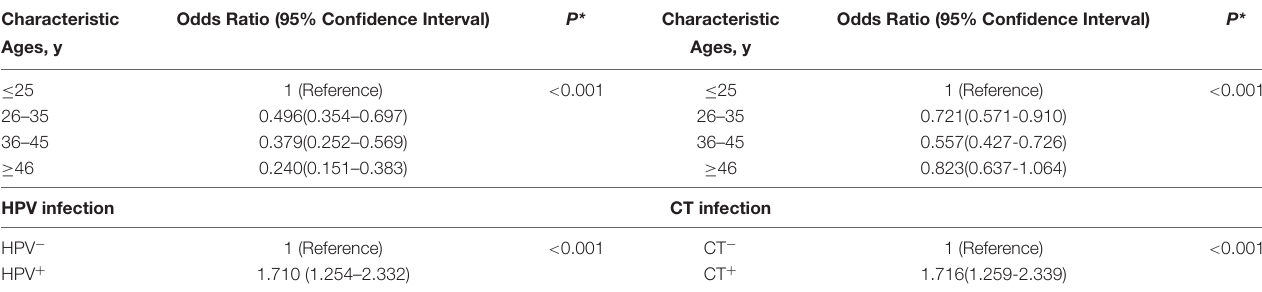
TABLE 2 | Factors associated with Chlamydia trachomatis or HPV infection by multivariate analysis. Characteristic